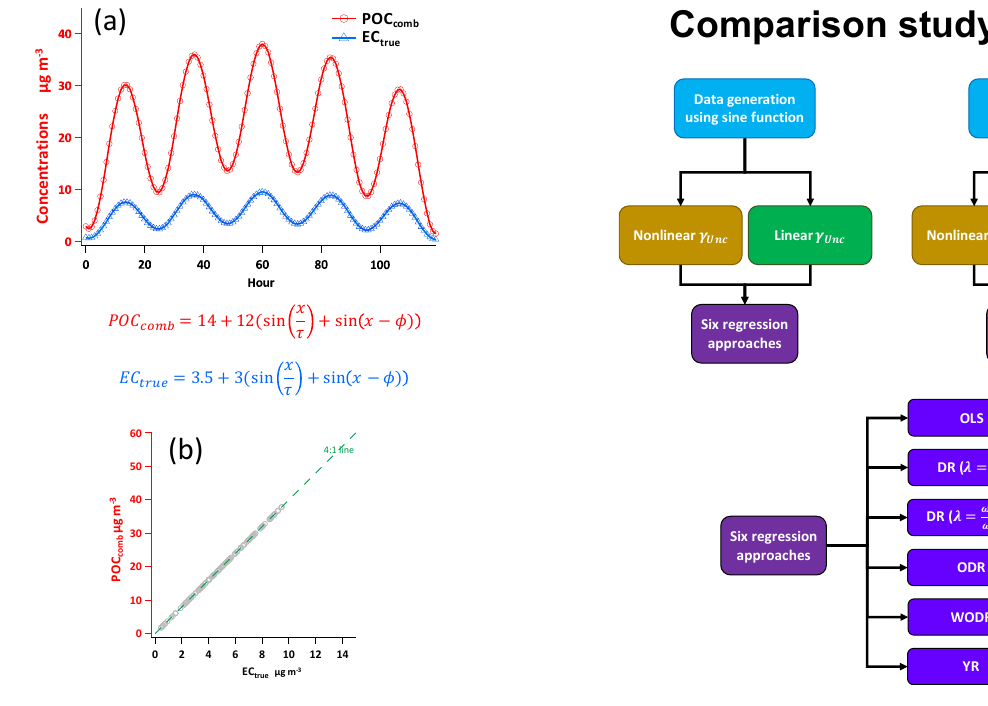
Figure 4. Overview of the comparison study